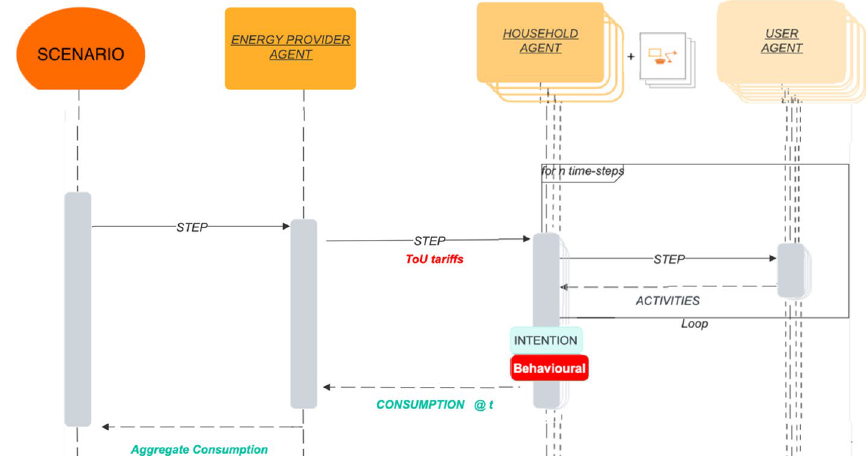
Fig. 14 Configuration of the Case study 3 . The generic “change” block of Fig. 2 has been replaced by the “behavioural” module in red allowing a simulation of the behaviour of the users under ToU